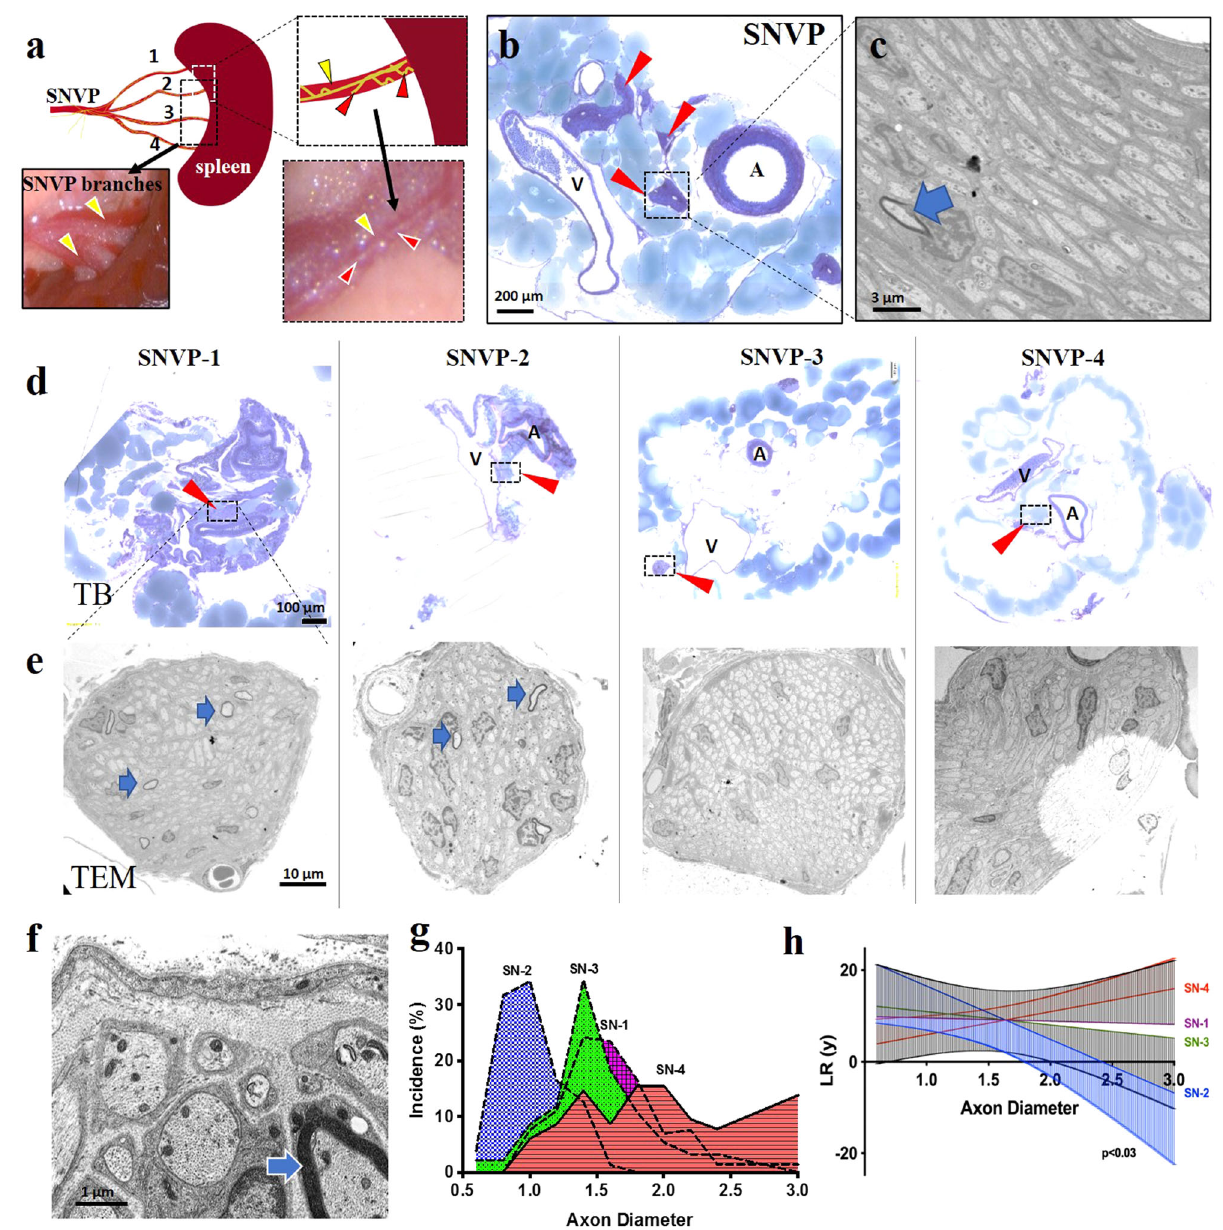
Fig. 3 Splenic neurovascular plexus asymmetric branching. a Schematic of the rat SNVP splitting into four-terminal branches prior to entering into the spleen. Inserts: Splenic vasculature (yellow arrowheads) and the SN (red arrowheads). b Toluidine blue (TB) staining, red arrows point to the location of the SN fascicles between the artery (A) and vein (V). c unmyelinated SN axons by TEM with a single myelinated axon (blue arrow). d Representative images of TB staining of the four-terminal SN branches, with nerve fascicles in inserts (red arrowheads). e TEM micrographs of axonal composition in each terminal branch. Myelinated axons (blue arrows) were observed in SN1 – 2, but not in SN 3 – 4. f High TEM magni fi cation of SN-2 axons. g Axon diameter distribution in the SN branches. h Linear regression analysis of axon diameter distribution. Kolmogorov – Smirnov normality test was used to determine the difference in axon diameter population in different groups ( n = 4 animals). Data are shown as mean (solid lines) and error (95 con fi dence interval; top for SN1 and SN4, and bottom for SN3 and SN2). SN1 – 4 are shown by different colors. SN splenic nerve, SNVP splenic neurovascular plexus, TEM transmission electron microscopy. The slope between SN-1 and SN-4 is signi fi cantly different ( p <